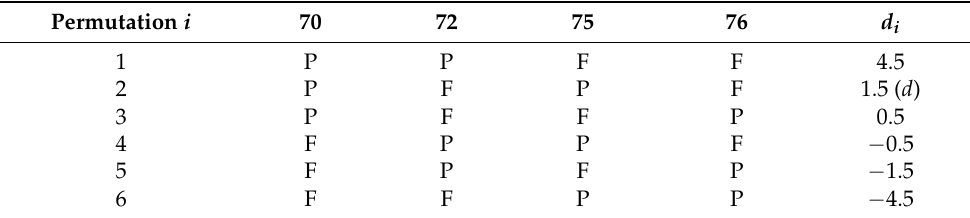
Table 2. Permutation possibilities based on the students scores where “P” and “F” refer to the pre-semester test and final